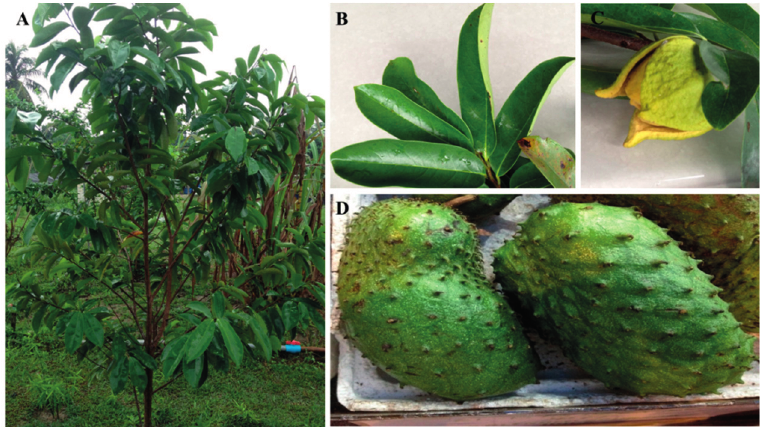
Figure 1. ( A ) Annona muricata L.; the appearance of the ( B ) leaves; ( C ) flowers